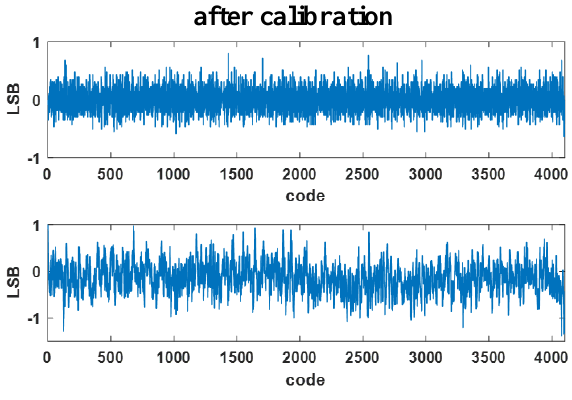
Figure 13. DNL and INL after calibration.